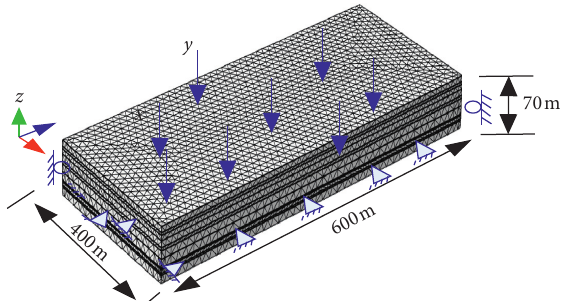
Figure 5: Numerical calculation model of the lower protective layer of #8 coal